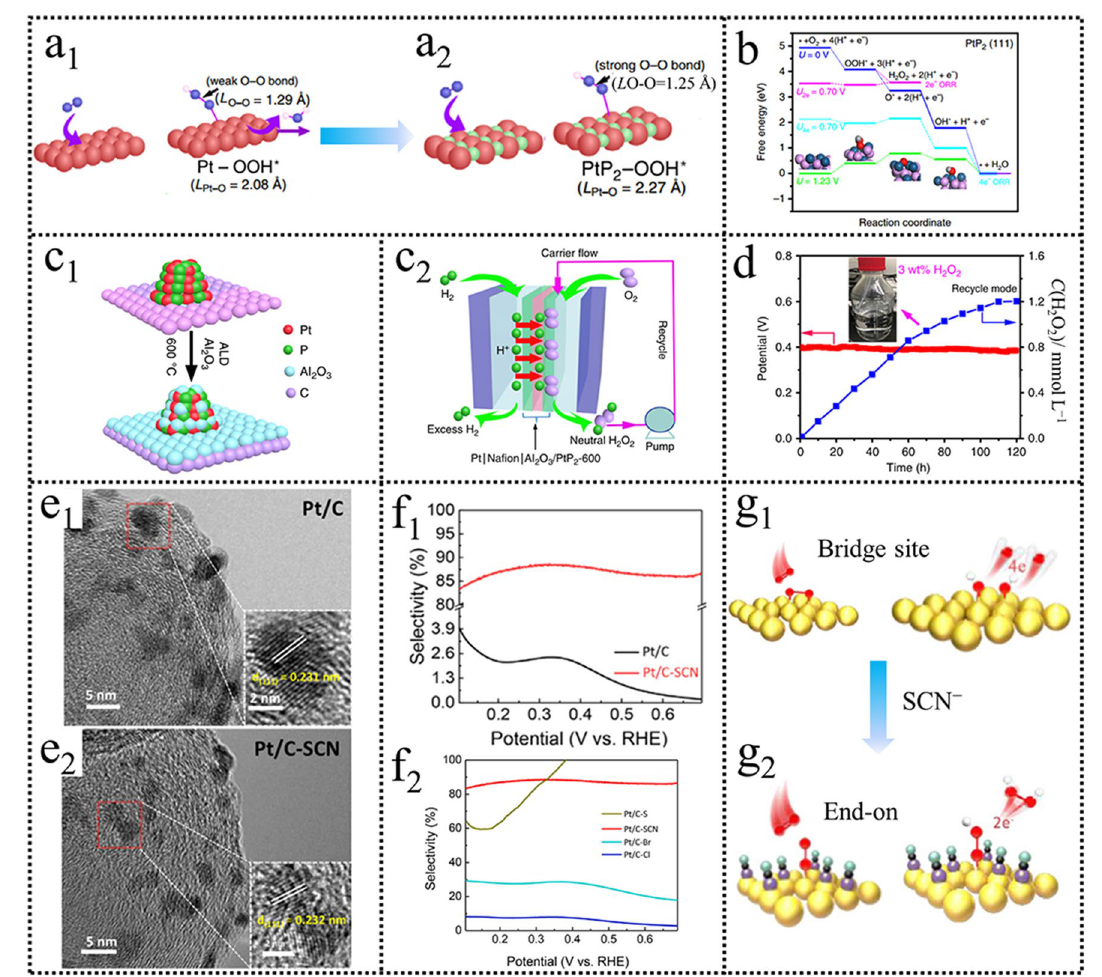
Fig. 7 a Difference between adsorption behavior of OOH* on bridge site of Pt and PtP 2 . b Free-energy diagram for the two-electron and four- electron ORR on PtP 2 . c Depiction of Al 2 O 3 coating by ALD and PEMFC for O 2 -to-H 2 O 2 production. d Time-dependent neutral H 2 O 2 concen- tration measured at a constant potential of 0.4 V ( vs . RHE) for 120 h. Reproduced with permission [64]. Copyright 2020, Springer Nature. e TEM images of Pt/C and Pt/C-SCN catalysts. f, g H 2 O 2 % selectivity and illustration of ORR transformation pathway for Pt/C catalysts before and after SCN − ion poisoning. Reproduced with permission [68]. Copyright 2021, Elsevier. (Color figure